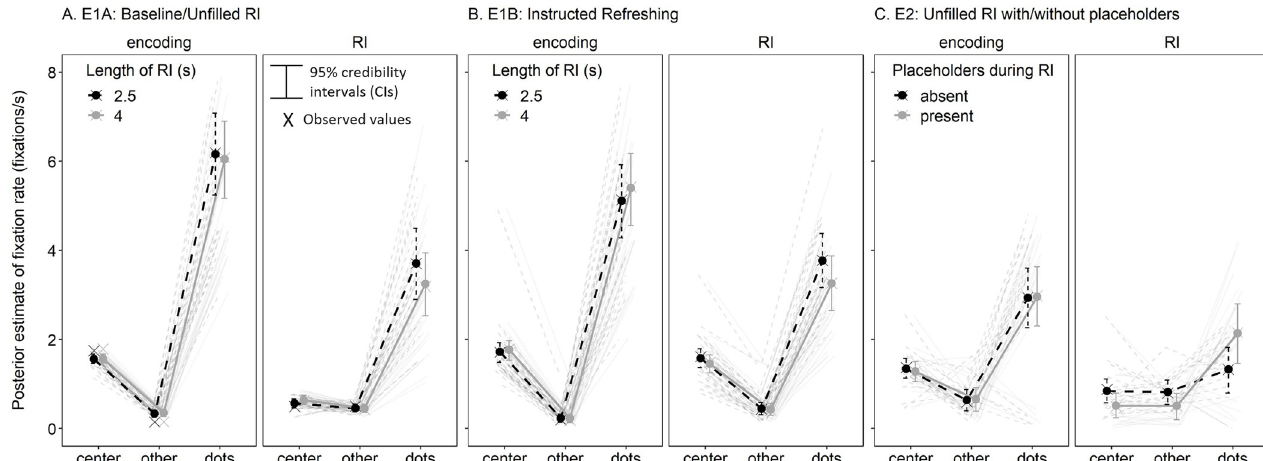
Fig 3. Research Question 1: Is There Evidence of Looking-at-Nothing During the Retention Interval (RI) of a Visual WM Task? Fixation Rate (Fixations per Second) Was Highest for Memory Locations (Dots) Compared to Center and Other Locations During Encoding and the RI in Experiments 1A (Panel A) and 1B (Panel B). For Experiment 2, Dot Fixations during the RI Were Only Credibly Higher When Placeholders Were Present (Panel C). The Dark Lines Represent the Posterior Means and the Lighter Individual Lines Represent Individual Participant Means. The Dots represent the Posterior Mean and the Xs Represent the Mean of the Observed